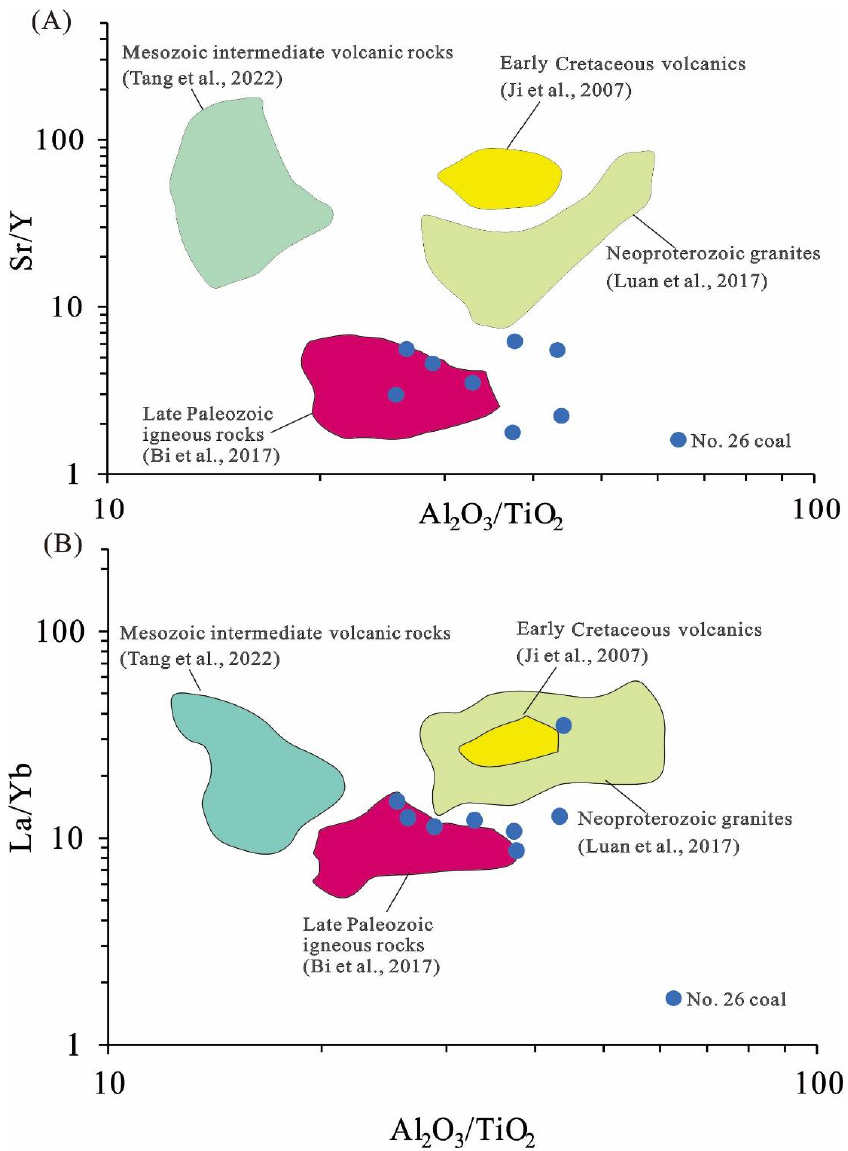
Figure 14. Comparison of ( A ) Al 2 O 3 /TiO 2 vs. Sr/Y and ( B ) Al 2 O 3 /TiO 2 vs. La/Yb between the studied samples, and the local (the Jiamusi block) rocks of Neoproterozoic, Late Paleozoic, Mesozoic and Cretaceous ages